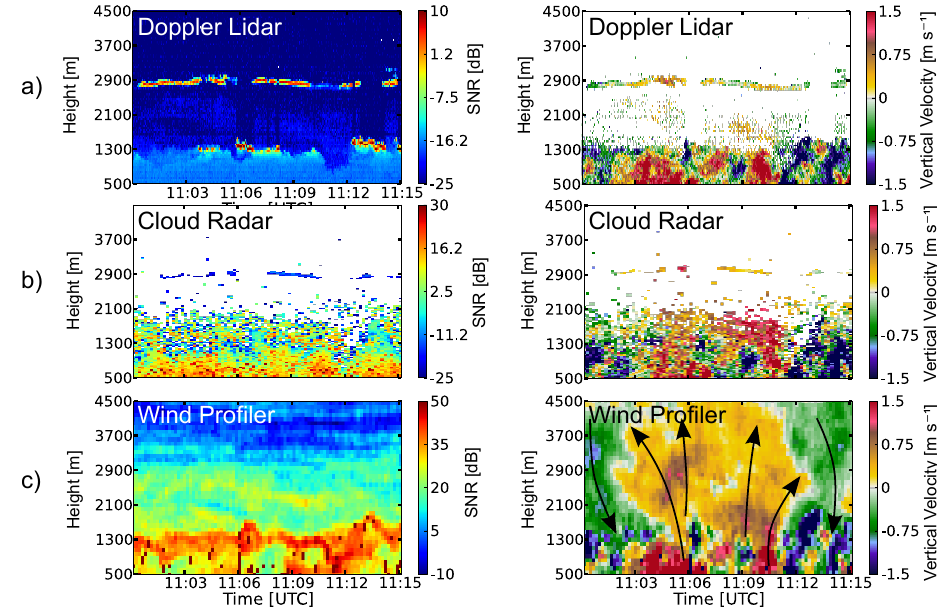
Figure 5. Magnified portion of Fig. 3 (pink dashed box, 11:00–11:15UTC). SNR of each single instrument is shown in left column, vertical velocity on the right. The wind profiler gives unambiguous information about the vertical velocity of air in the vicinity of the cloud, which is detected by the Doppler lidar and partly by the cloud radar.